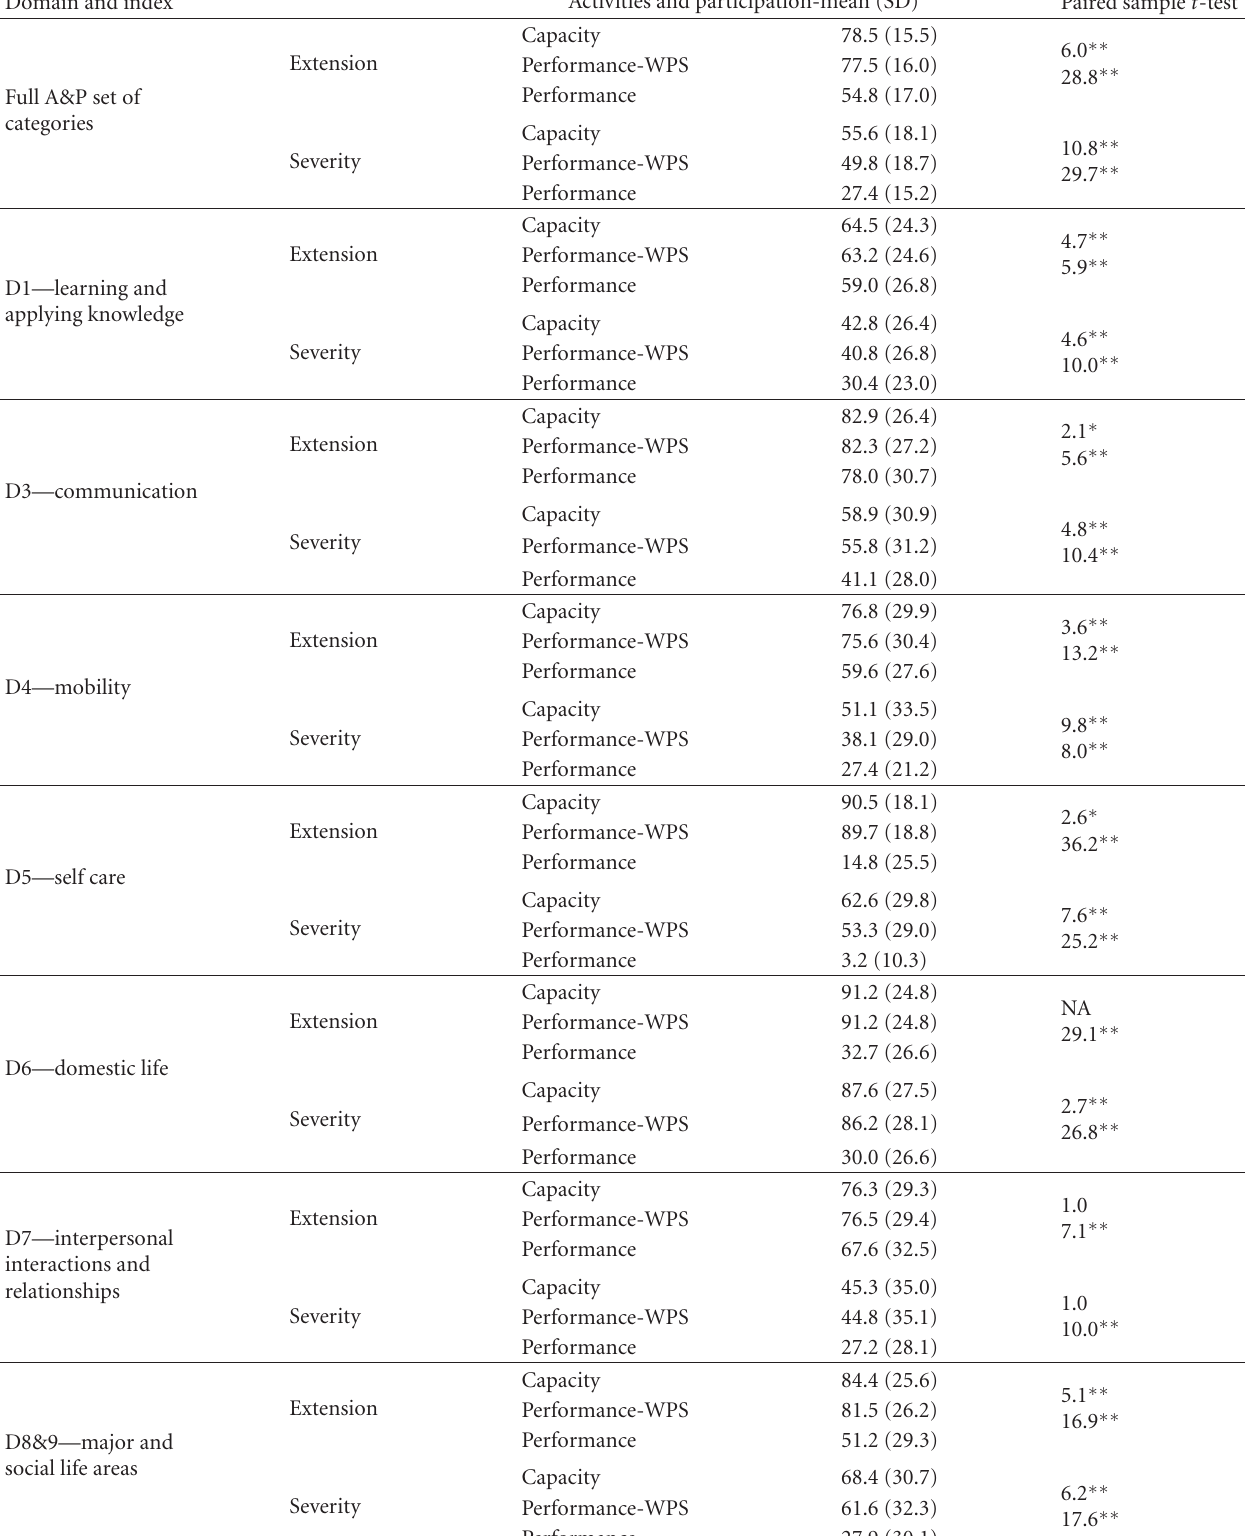
Table 2: Paired-sample t- test between A&P qualifiers of capacity, performance-WPS, and performance ( N = 200). Domain and